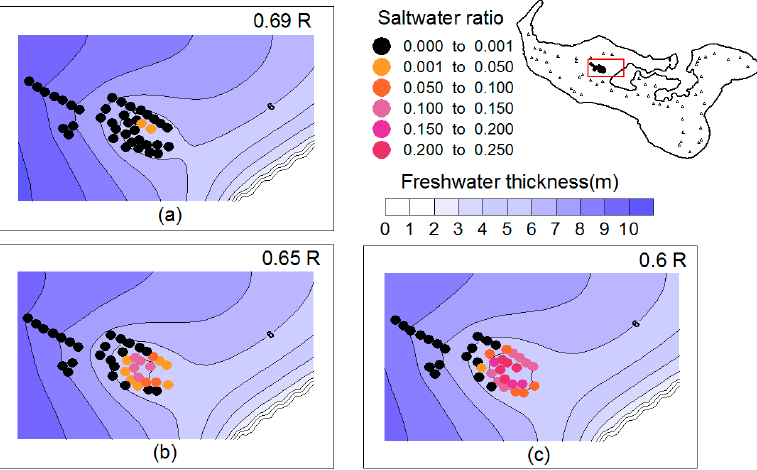
Figure 6. Saltwater intrusion into public wells under decrease in base recharge rates (R = 570 mm/year) ( a ) 69% of base recharge, ( b ) 65% of base recharge, and ( c ) 60% of base recharge.